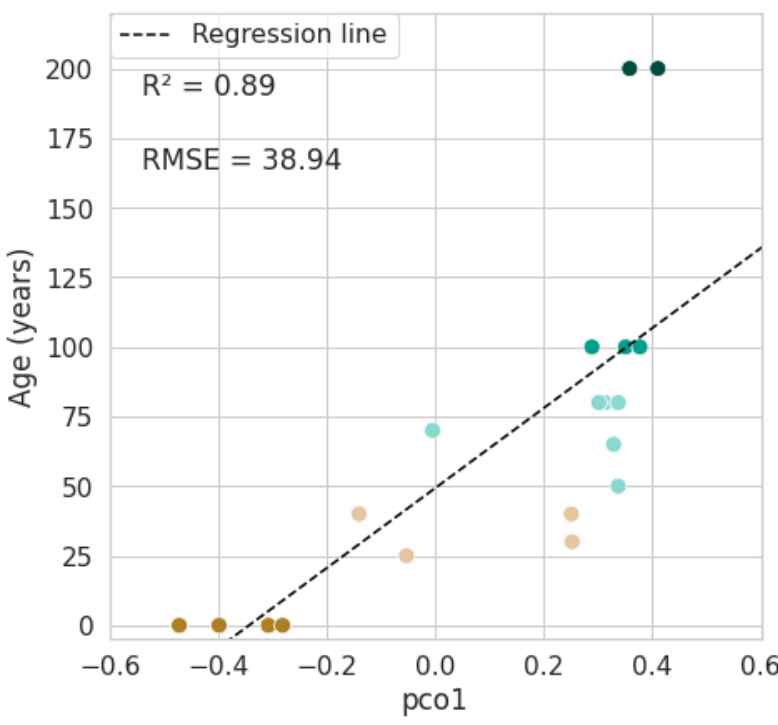
Figure 8. Relationship between plot age in years and the values of the first component of the PCoA.